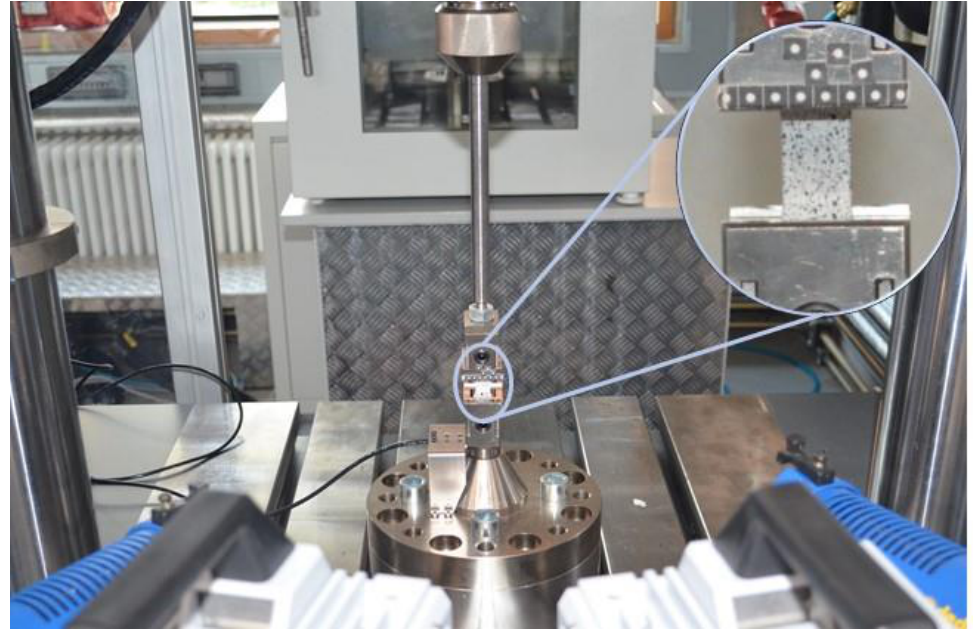
Figure 10. Experimental setup with lower and upper clamping and speckled specimen.